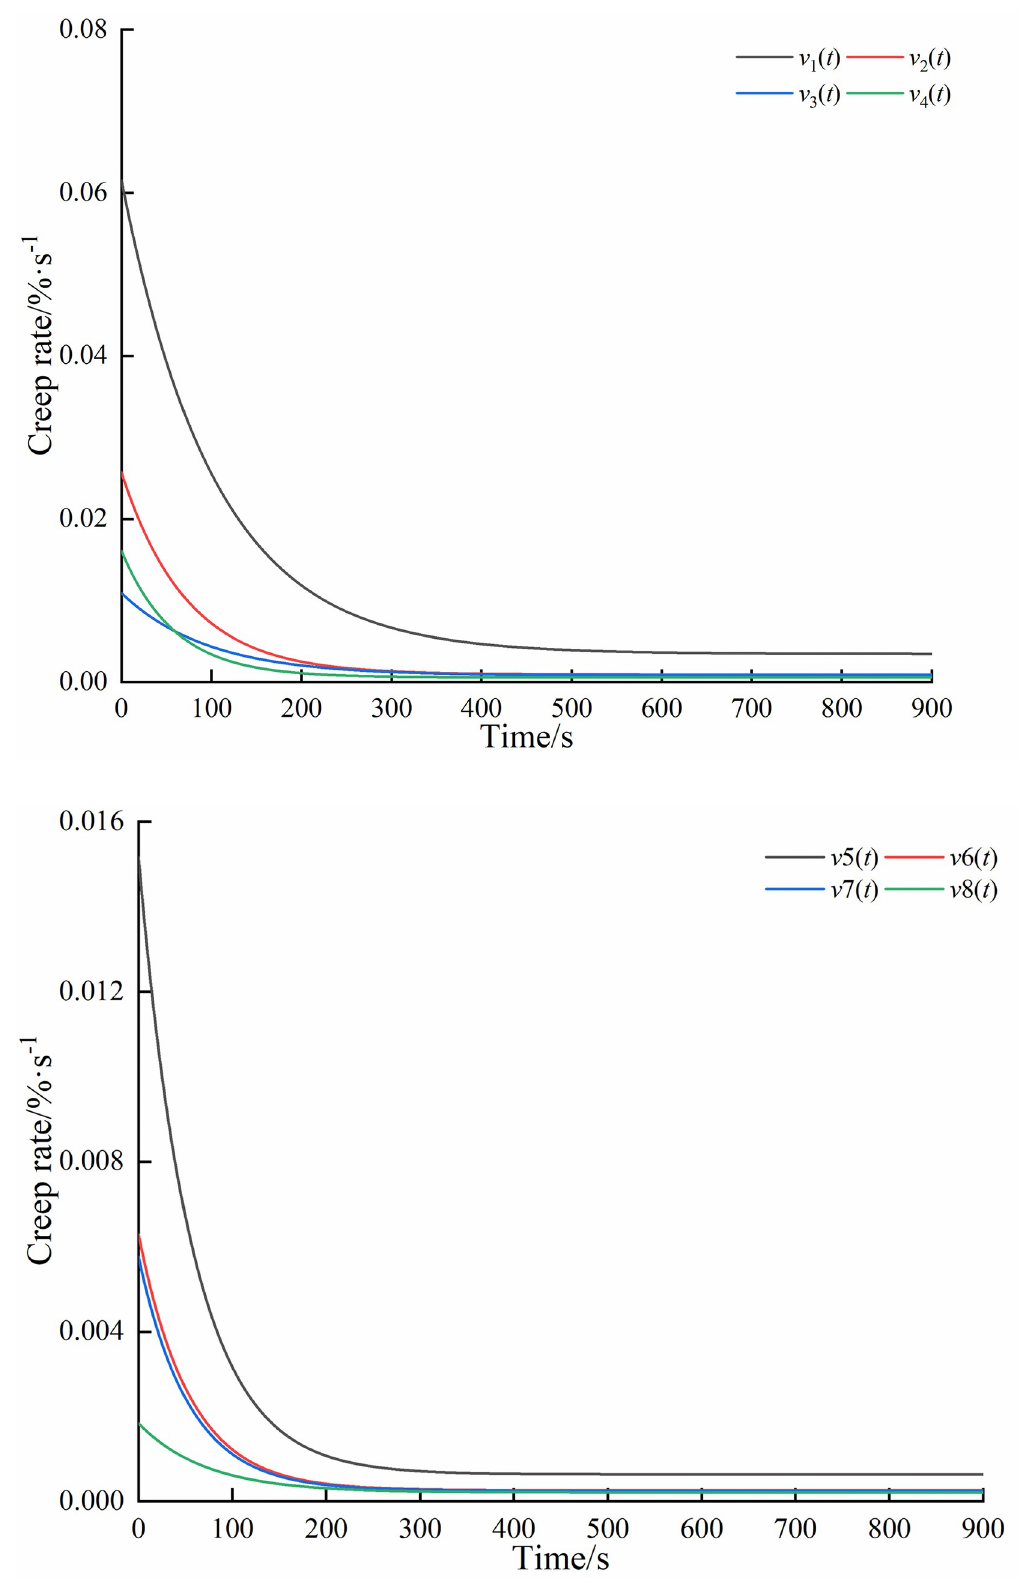
Fig 8. Deformation rate curve under different moisture content. (a) No tillage; (b) Plough tillage. https://doi.org/10.1371/journal.pone.0253623.g008 PLOS ONE | https://doi.org/10.1371/journal.pone.0253623 June 24,